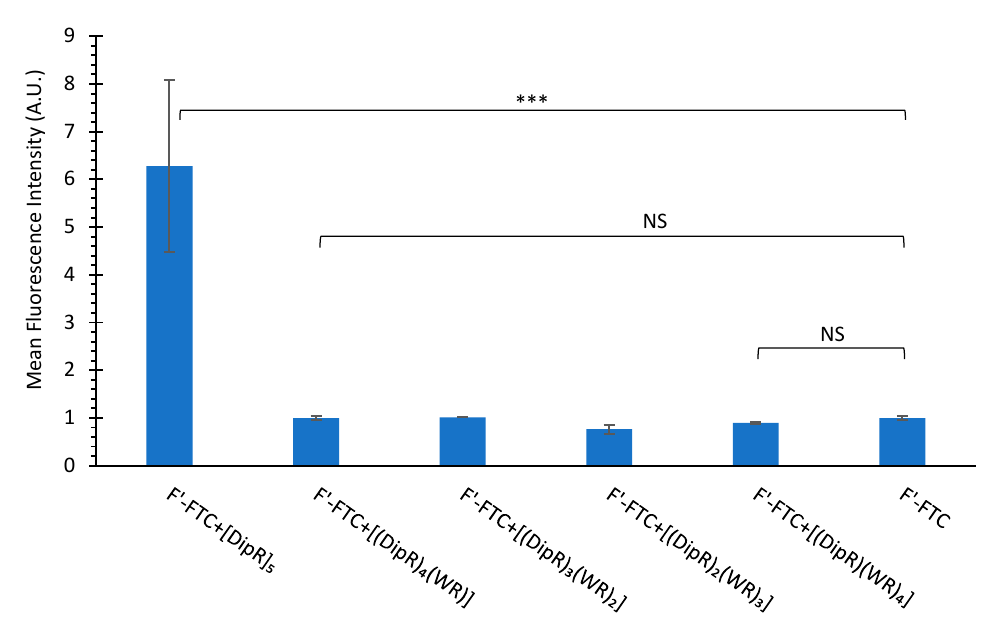
Figure 8. Cellular uptake of F’-3TC (2 µM) in the presence of cyclic peptides (10 µM) for SK-OV-3 cells after 3 h incubation. Results are mean ± SD (n = 3) (*** p < 0.001, NS = Not Significant). There was a difference in the cellular uptake of various fluorescent-labeled